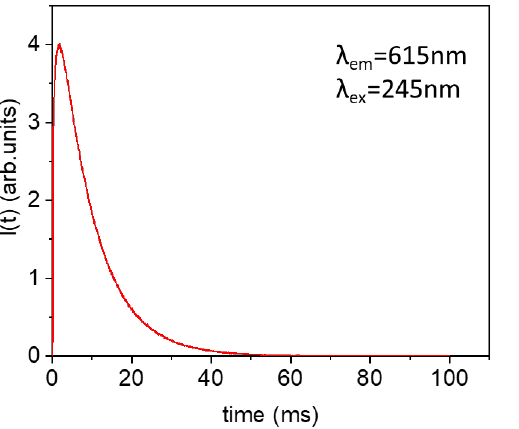
Figure 6. Experimental decay curve from 5 D 0 level of Eu 3+ in 1.5Eu 3+ : NaGdF 4 NPs heat-treated at 450 °C for 5 h, taken under excitation at 245 nm and collecting the luminescence at 615 nm. 3.4. Luminescence Properties of 80SiO 2 -20(1.5Eu 3+ NaGdF 4 ) OxGCs The luminescent properties of the OxGCs powders with the composition 80SiO 2 - 20(1.5Eu 3+ -20NaGdF 4 ) heat-treated at 450 °C for 5 h are presented in Figure 7a, which shows the emission spectrum recorded under excitation at 245 nm. The spectral features are similar to those obtained for 1.5Eu 3+ : NaGdF 4 NPs, with the peaks revealing the tran- sition 6 P 0 → 8 S 7/2 of Gd 3+ and the 5 D 0 → 7 F J transition from the Eu 3+ ion. In addition to the nanoparticles study, the most intense peak was found to be corresponding to the 5 D 0 → 7 F 2 transition, in agreement with a non-centrosymmetric site for the Eu 3+ ion. In this case, wavelength of the emissions is the same as that detected for the nanoparticles reported in the previous section.